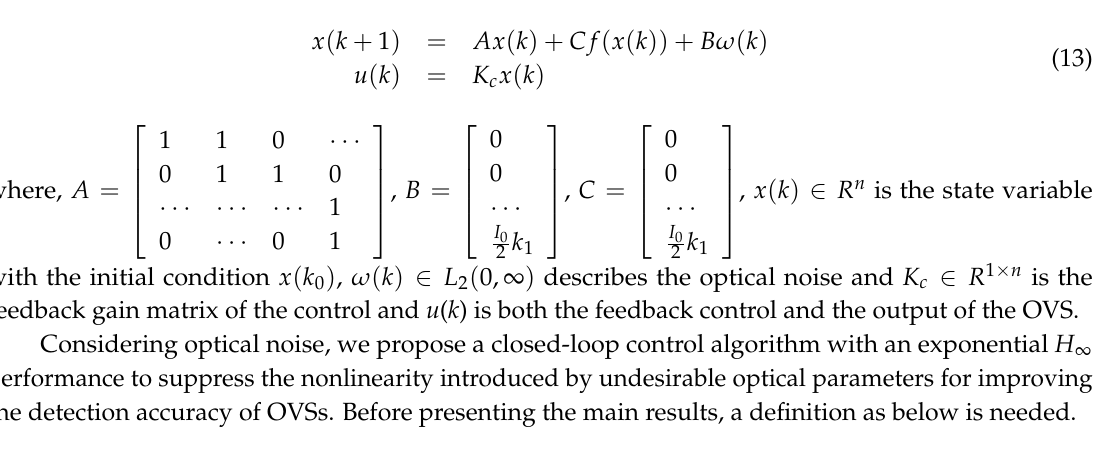
Figure 6. The influence of ν and θ on the measurement accuracy of closed-loop OVS.